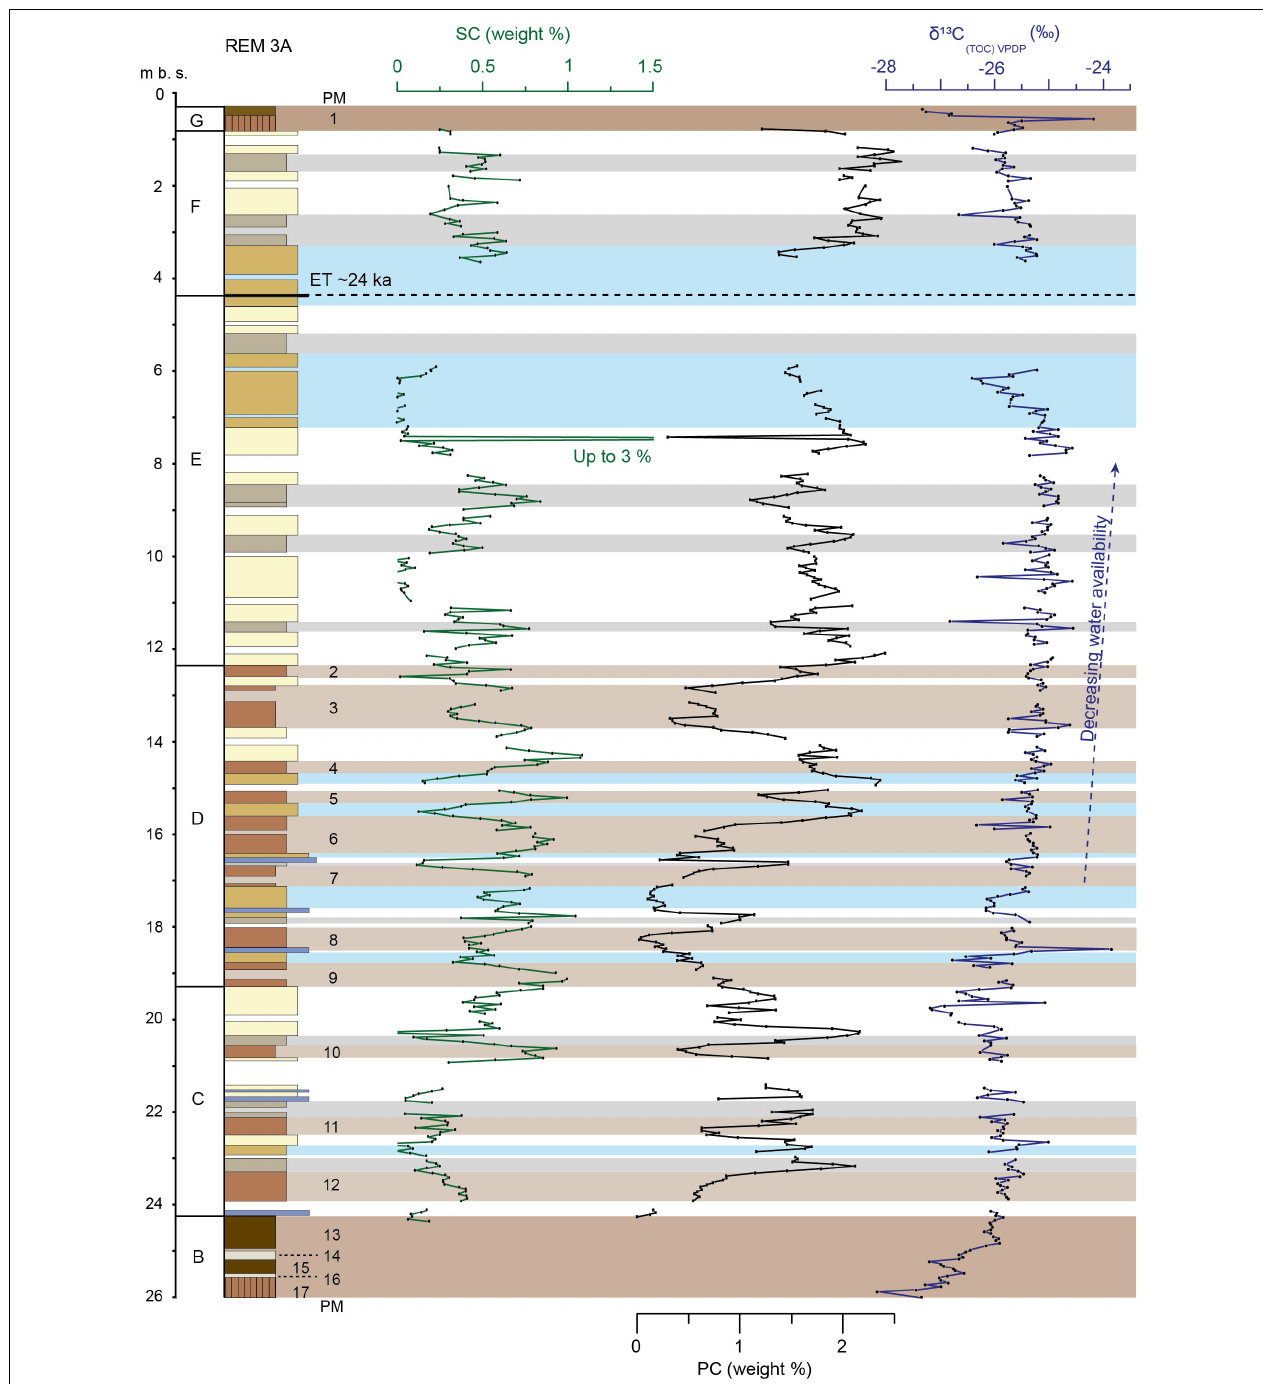
FIGURE 5 | Calculated primary and secondary carbonate contents (in weight % of TIC, see Figure 4 ) and δ 13 C ( TOC ) VPDB . The latter reflects water availability of plants within loess and reworked loess layers, whereas in soils decomposition has to be considered (see Figure 6 ). Gelic Gleysols are indicated by grey bars, Calcaric Cambisols by light brown bars and soil horizons associated with interglacial and early glacial conditions are represented by dark brown bars. Note that the lowermost part of unit (B) and the entire Holocene topsoil (A) are decalcified. Thus, no values are depicted. Estimated age of the Eltville-Tephra according to Zens et al. (2017) and Förster et al. (2020). Litho- and pedostratigraphic legend according to Figure 3 .